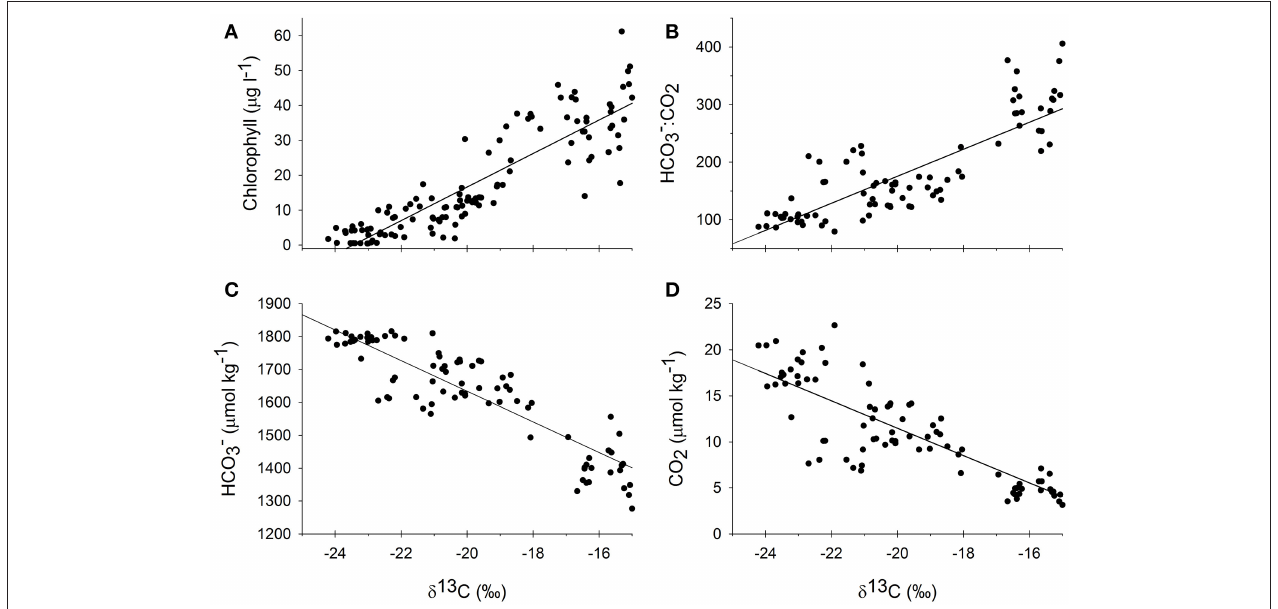
FIGURE 5 | Measured δ 13 C values over the course of all three experiments from all culture vessels plotted against chlorophyll (A) , the ratio of bicarbonate to carbon dioxide (B) , carbon dioxide (D) , and bicarbonate (C) concentrations that were collected at the same time. Regressions were all highly significant ( p < 0.001) where the regression equation for δ 13 C against chlorophyll was y = 4.80x + 113 ( R 2 = 0.81), against HCO − 3 :CO 2 was y = 23.4x + 644 ( R 2 = 0.71), against CO 2 was y = − 1.48x − 18.2 ( R 2 = 0.71), and against HCO − 3 was y = − 46.5x + 703 ( R 2 =